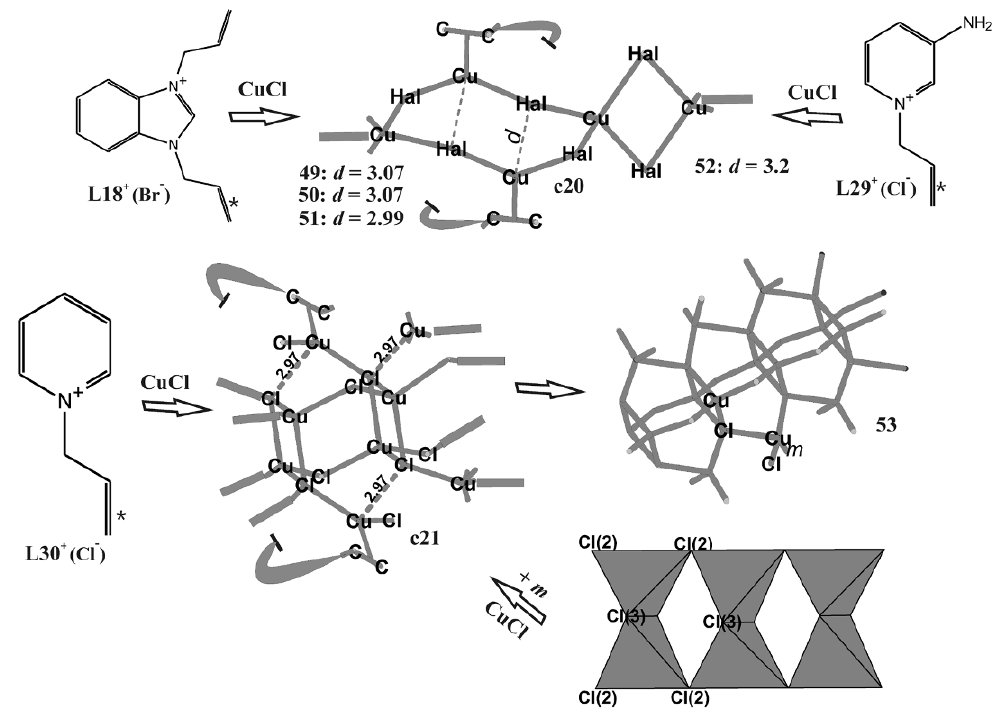
Figure 10. Structural genesis of C20 and C21 fragments in 49-53